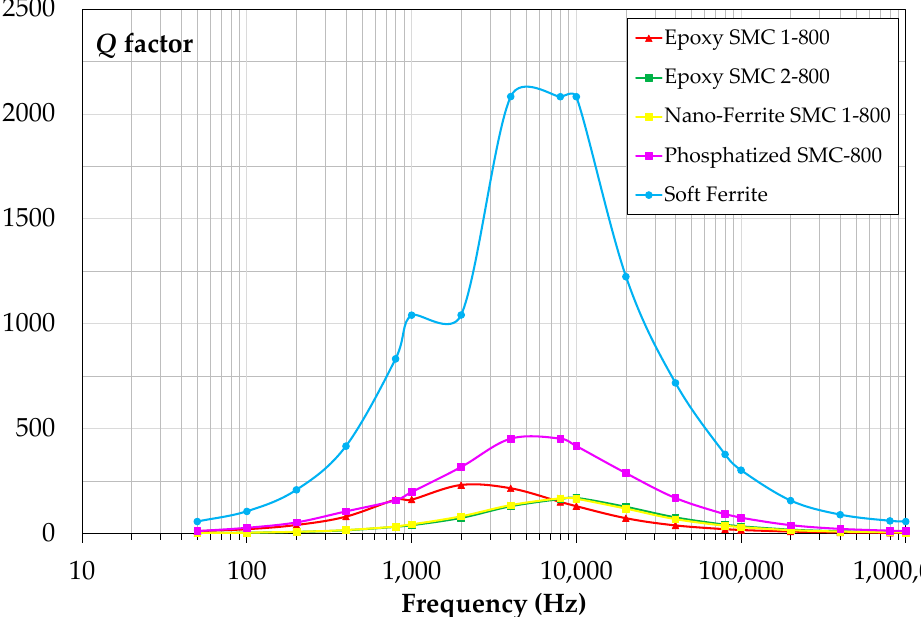
Figure 15. The Q factor of the rod samples of proposed SMC materials compared to soft ferrite .